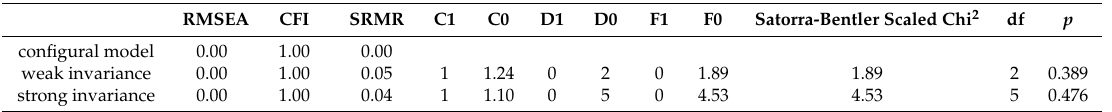
Table A5. Measurement Invariance of Intrinsic Research